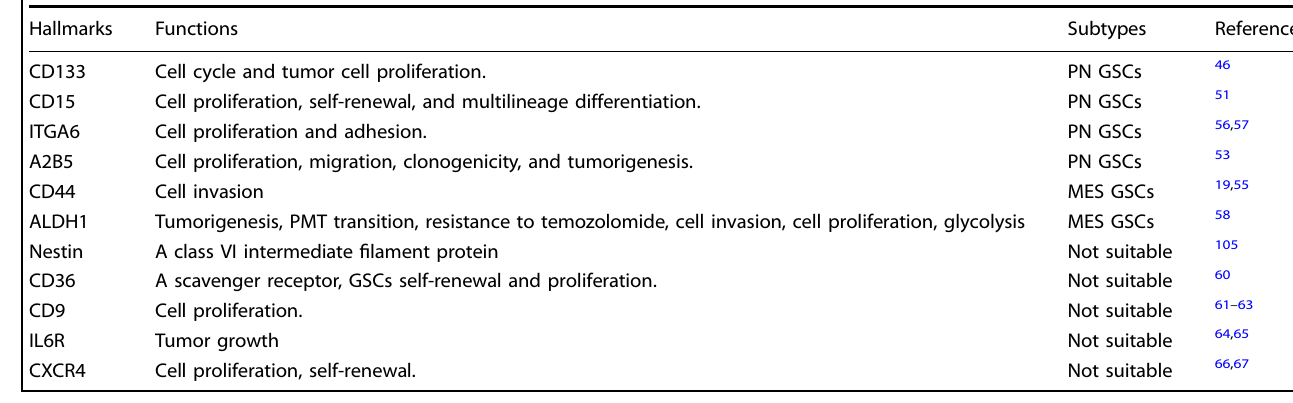
Table 2. The basic characteristics of PN GSCs and MES GSCs Difference PN GSCs MES GSCs Hallmarks CD133, CD15, MAP2, SOX2, OLIG2, IDH1-mutant and EZH2 CD44, ALDH1A3, EGFR, YKL40, IDH1-wildtype, BMI1 and GFAP Signaling pathways